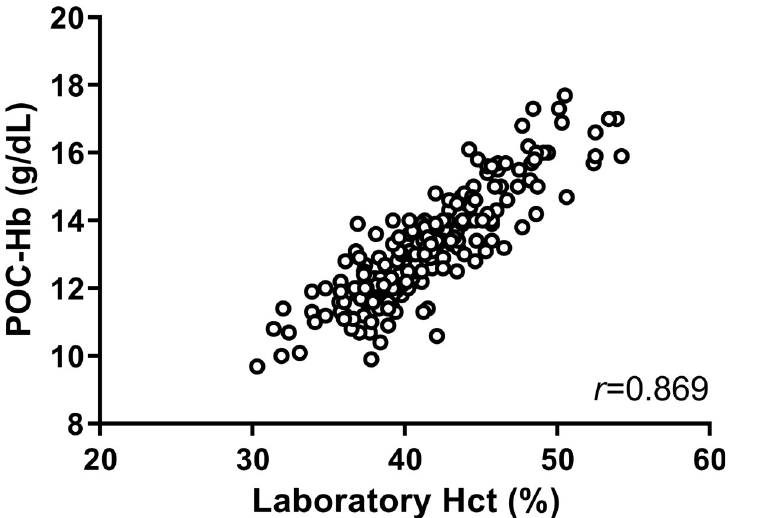
Fig 3. Scatter plot of point-of-care hemoglobin and laboratory hematocrit.